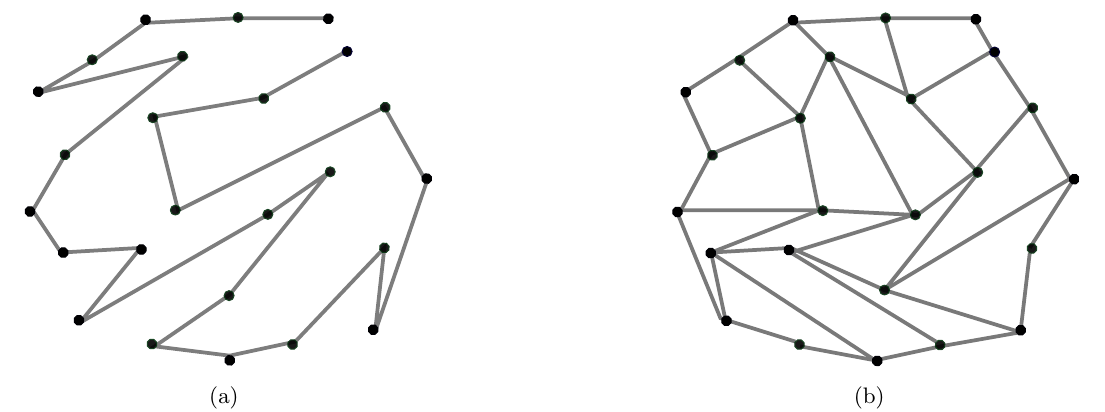
Figure 3 . Entanglement bonds that exhibit one and two dimensional local structures,